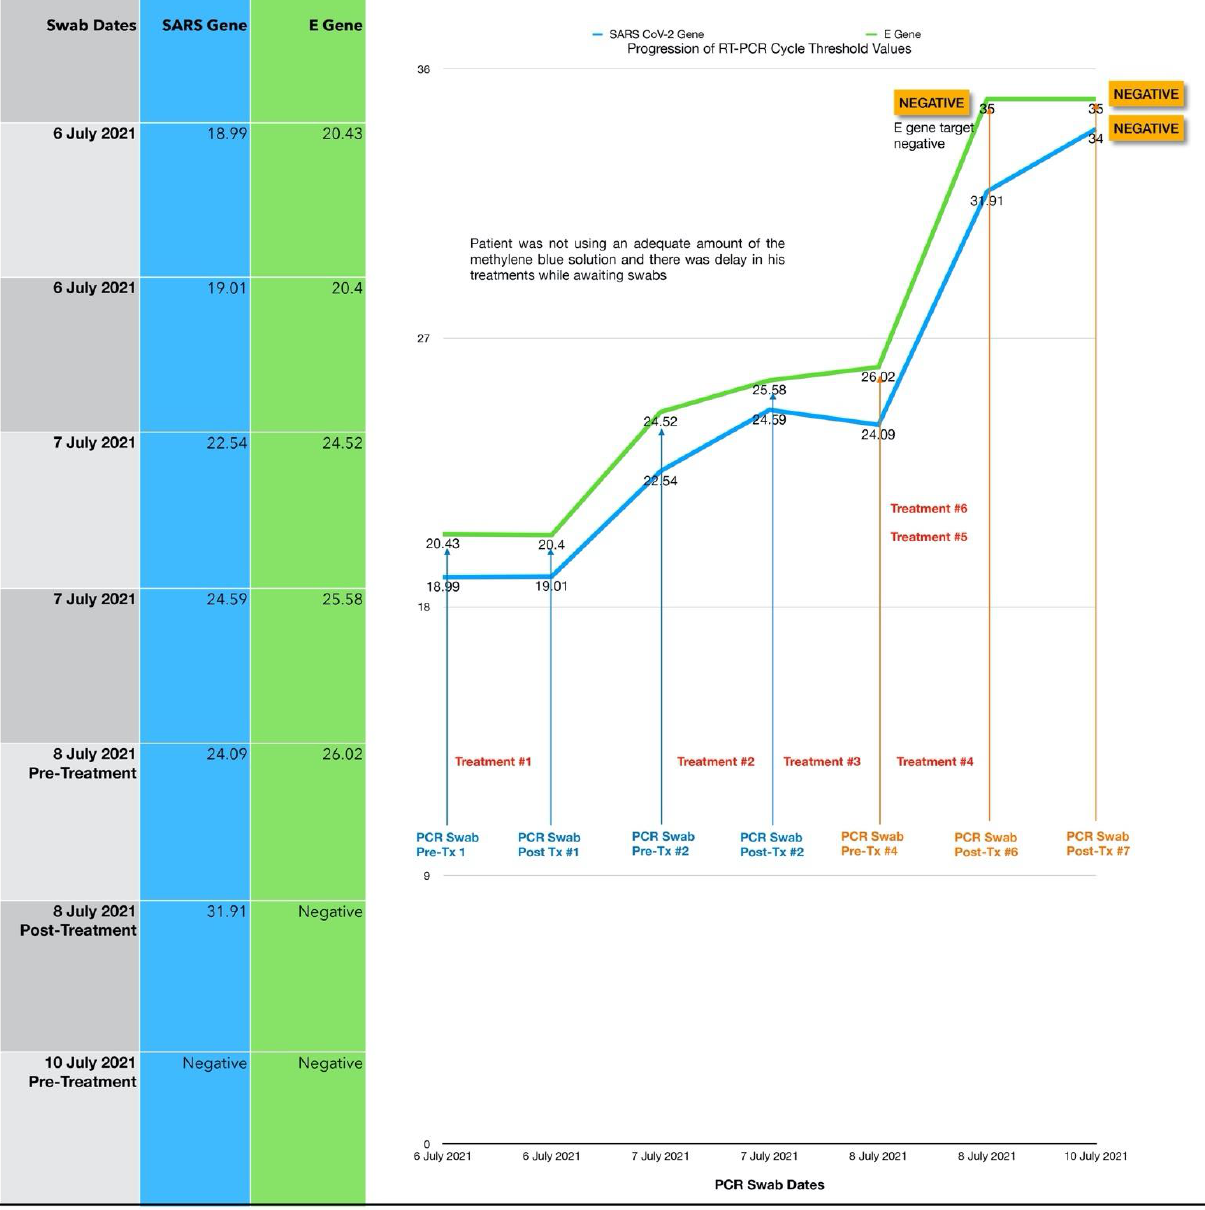
Figure 7. Shows the serial CT values of subject